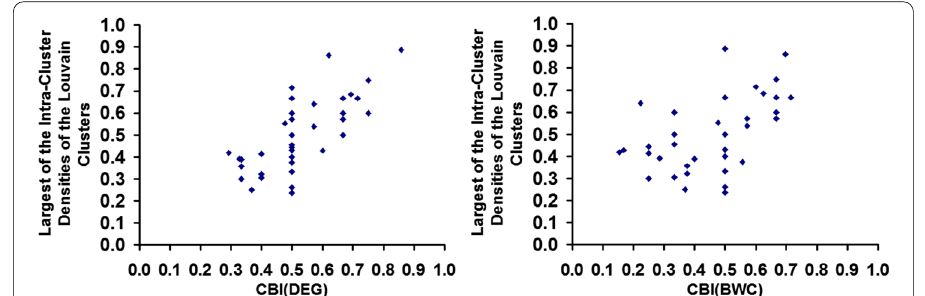
Fig. 8 Largest of the intra-cluster densities of the Louvain clusters versus the CBI values for the complex real-world networks